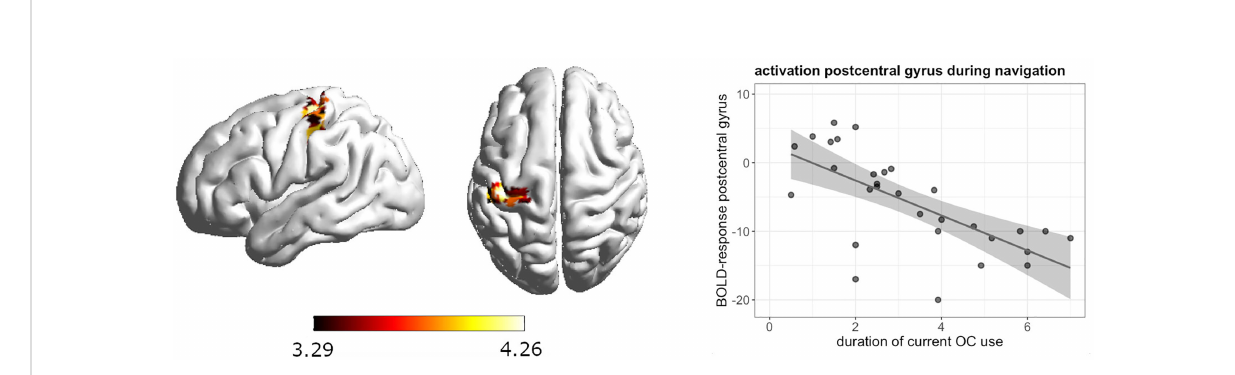
FIGURE 3 Negative association between duration of OC use and left postcentral gyrus activation during navigation in current androgenic OC